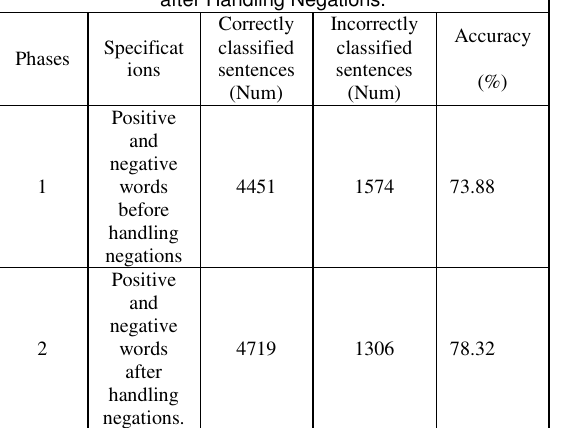
Table 2: Accuracy of Urdu Sentiment Analyzer before and after Handling Negations.